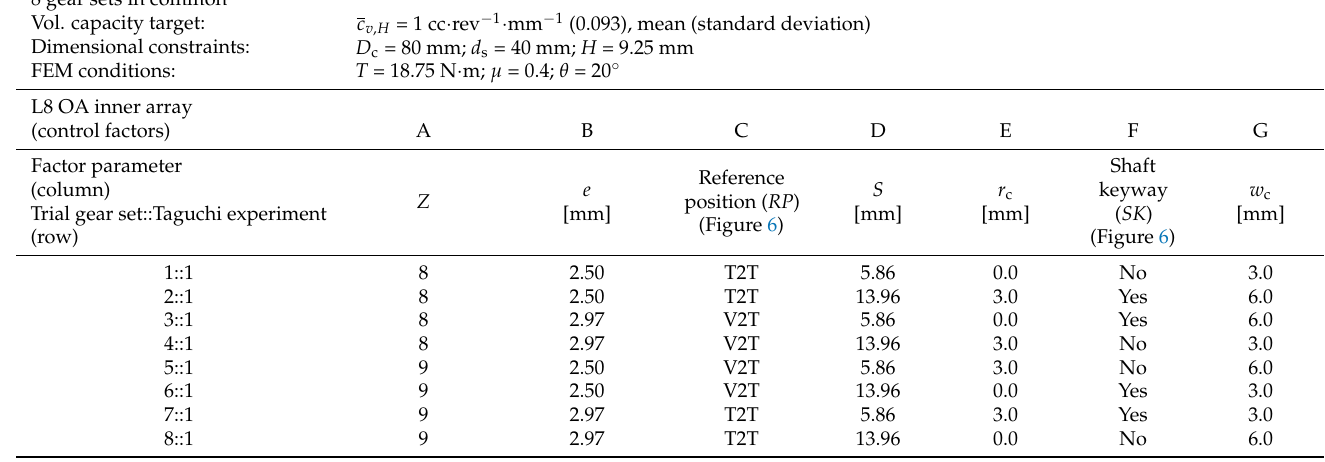
Table 4. The parameter design table of the screening case of the first Taguchi experiment. (Please refer to Nomenclature section and Figure